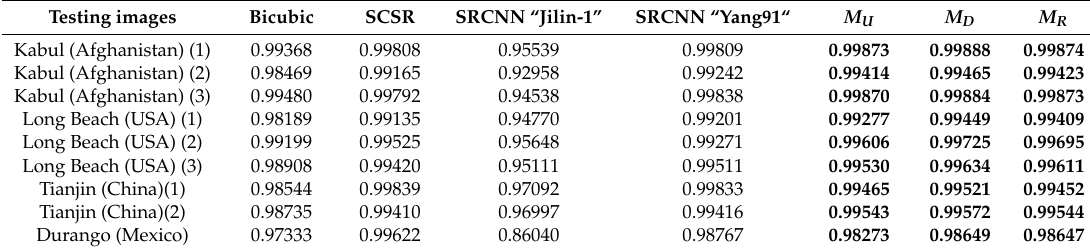
Table 3. Structural similarity (SSIM) of comparison methods. M U , M D , and M R represent the three kinds of networks described in Section 2.1. Yang91 is a standard training set that was firstly used by Yang